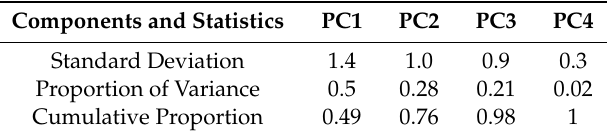
Table 1. Importance of principal components